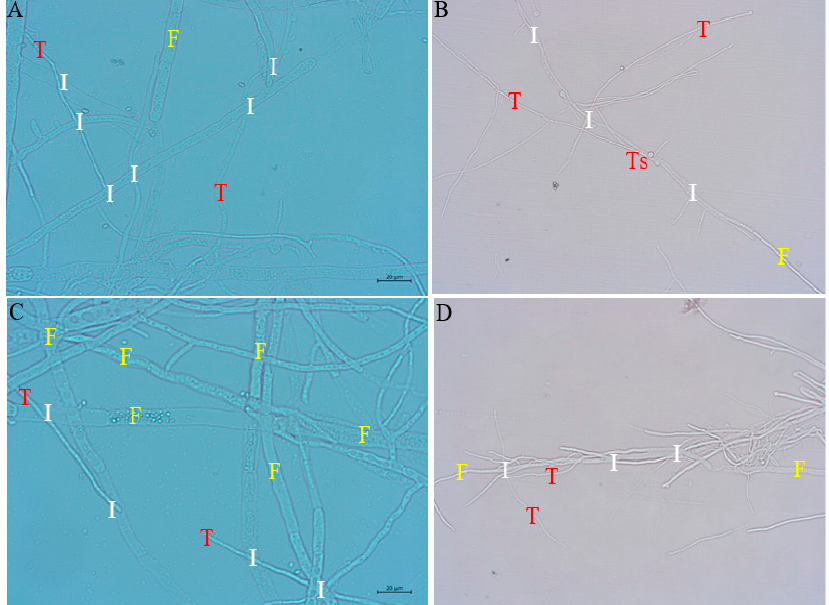
Figure 2. Mycoparasitism of T. longibrachiatum (TL6 and TL13) against Fusarium solani (FSH) and Fusarium avenaceum (FAH) was observed under light microscopy at x40 magnification. ( A ) Internal and external growth of TL6 conidial on F. avenaceum hyphae. ( B ) TL13 spore germ tube (Ts) developing on the hyphae, with TL13 conidial growing parallel to F. solani , demonstrating hyphae depression. ( C ) TL13 penetration, disruption, and breakage of F. avenaceum hyphae and ( D ) TL6-wrapped around F. solani hyphae, causing cell wall degradation. T represents Trichoderma hyphae, F represents Fusarium hyphae, and I represents the point of interaction.